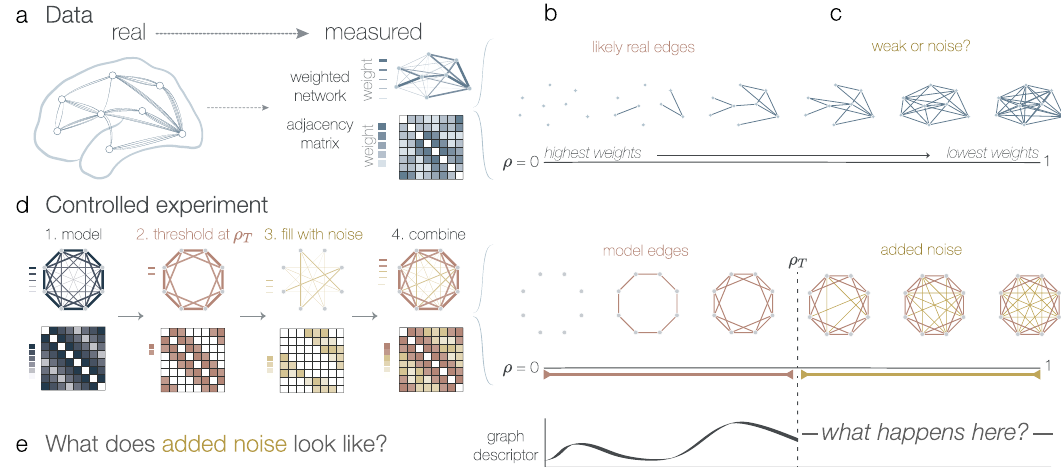
Fig. 1 Our experiments query the structure of noise added to model networks. a A schematic of real data from a structural brain network. Such data are often assumed to consist of strong and likely real edges ( b ), along with weak edges ( c ) that could arise simply due to noise in the system or in the measurements. Edge density denoted by ρ . d In our experiment, we begin with a model network (step 1, navy, network and adjacency matrix), threshold the model network to a speci fi c edge density ρ T (step 2, rose, network and adjacency matrix), fi ll the thresholded edges with weaker, noisy edges (step 3, gold, network and adjacency matrix) to form a combined network (step 4, rose and gold, network and adjacency matrix). e Then we will measure the structure of the noisy edges